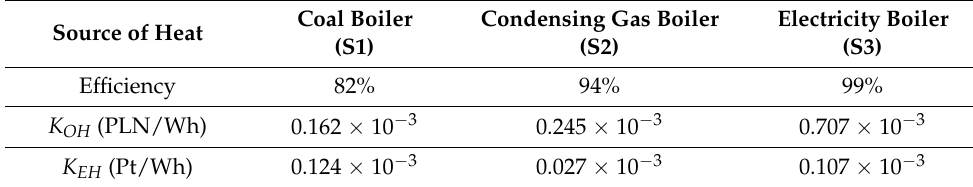
Table 3. Heat sources.